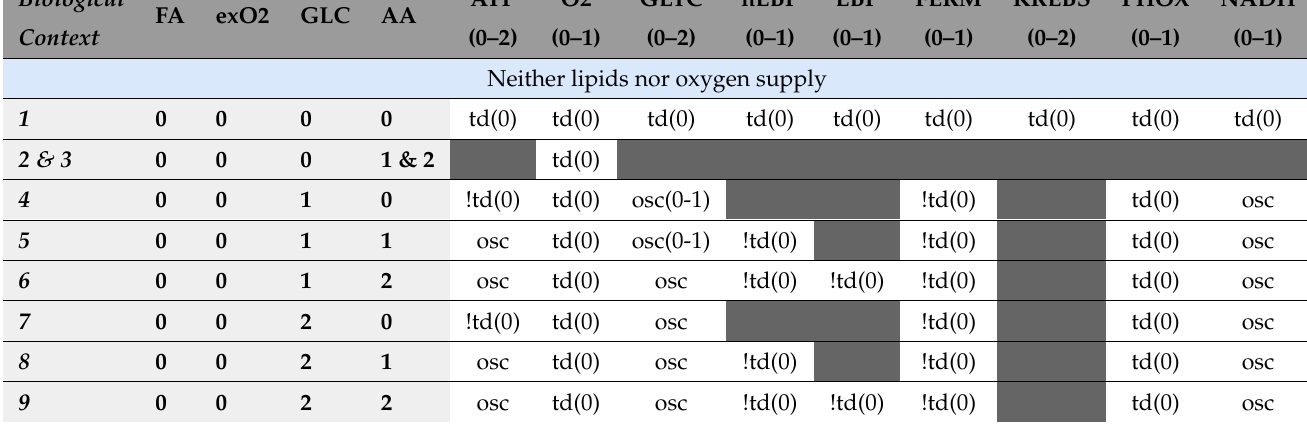
Table 2. Validation matrix for the cell metabolism regulation model. Each row (resp. column) represents an experimental condition (resp. an observable systemic variable). Thus, each box of the table formalizes the known behavior of that observable variable in that experimental condition. Grey boxes refer to missing knowledge depending on the cell type or more generally knowledge which we do not consider as consensus. Lines 16, 17, 18, 34, 35 and 36 formalize the Warburg/Crabtree